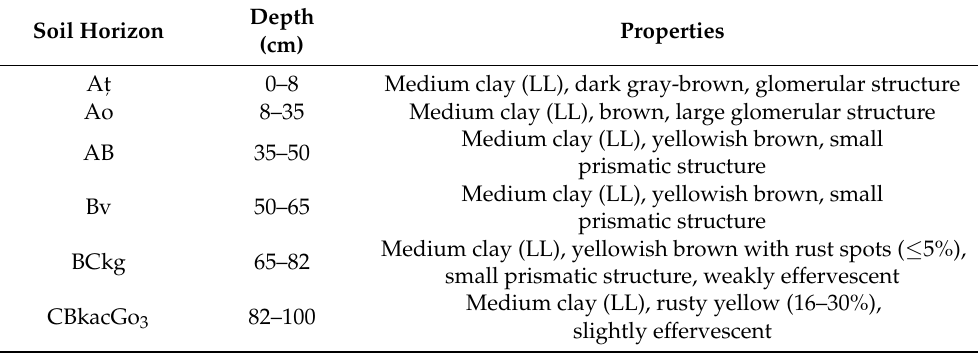
Table 2. Presentation of the soil profile horizons SP1, P808, pastures agricultural